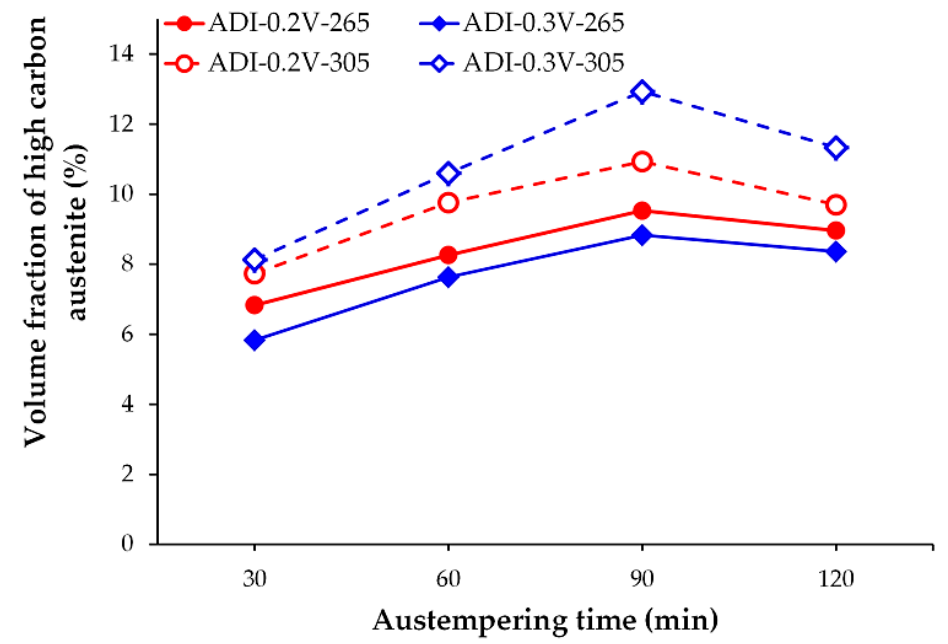
Figure 9. Effect of the austempering time on the high ‐ carbon austenite formation.